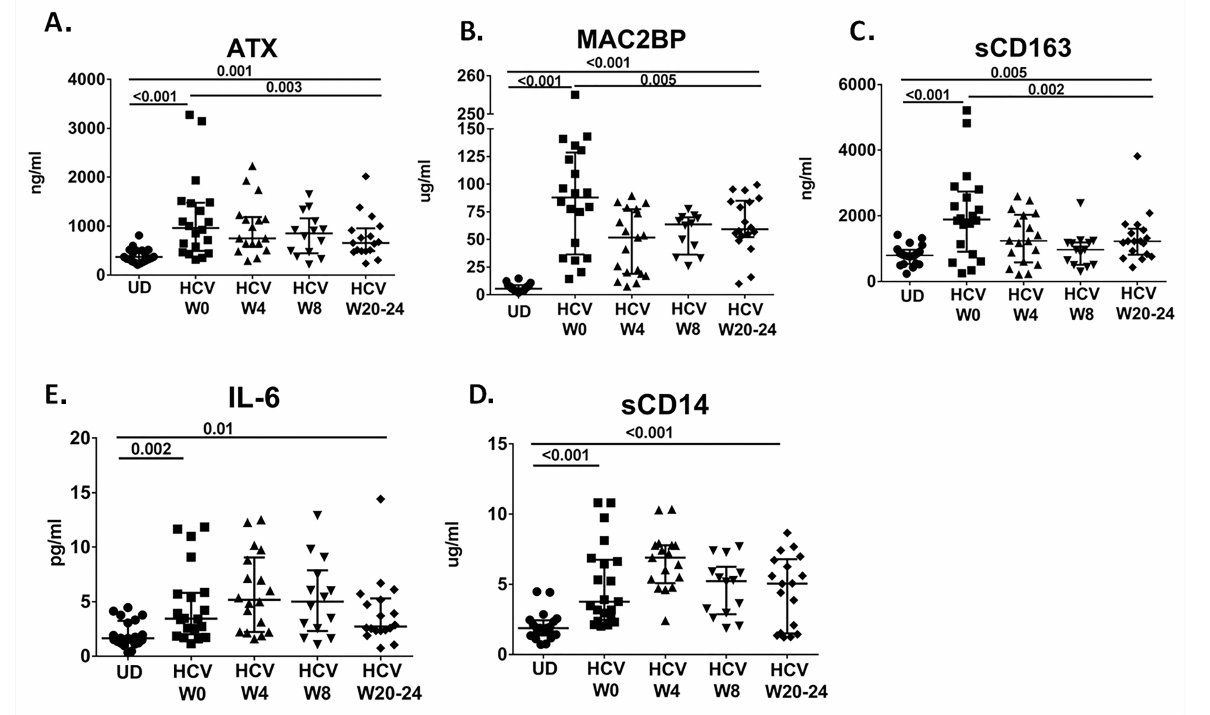
Figure 2. Partial normalization of inflammatory parameters over the course of IFN-free DAA therapy. Plasma levels of A) Autotaxin (ATX), B) Mac2BP, C) sCD163, D) IL-6 and E) sCD14 are shown over